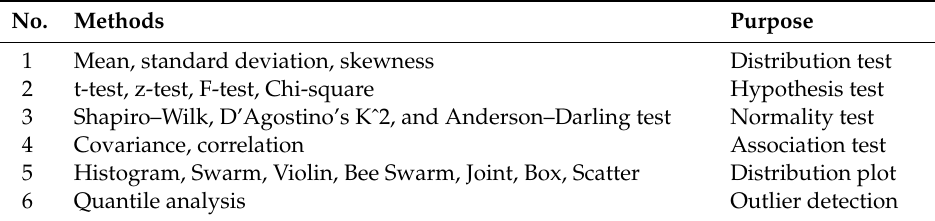
Table 6. Statistical analysis methods on the selected datasets [32,39].